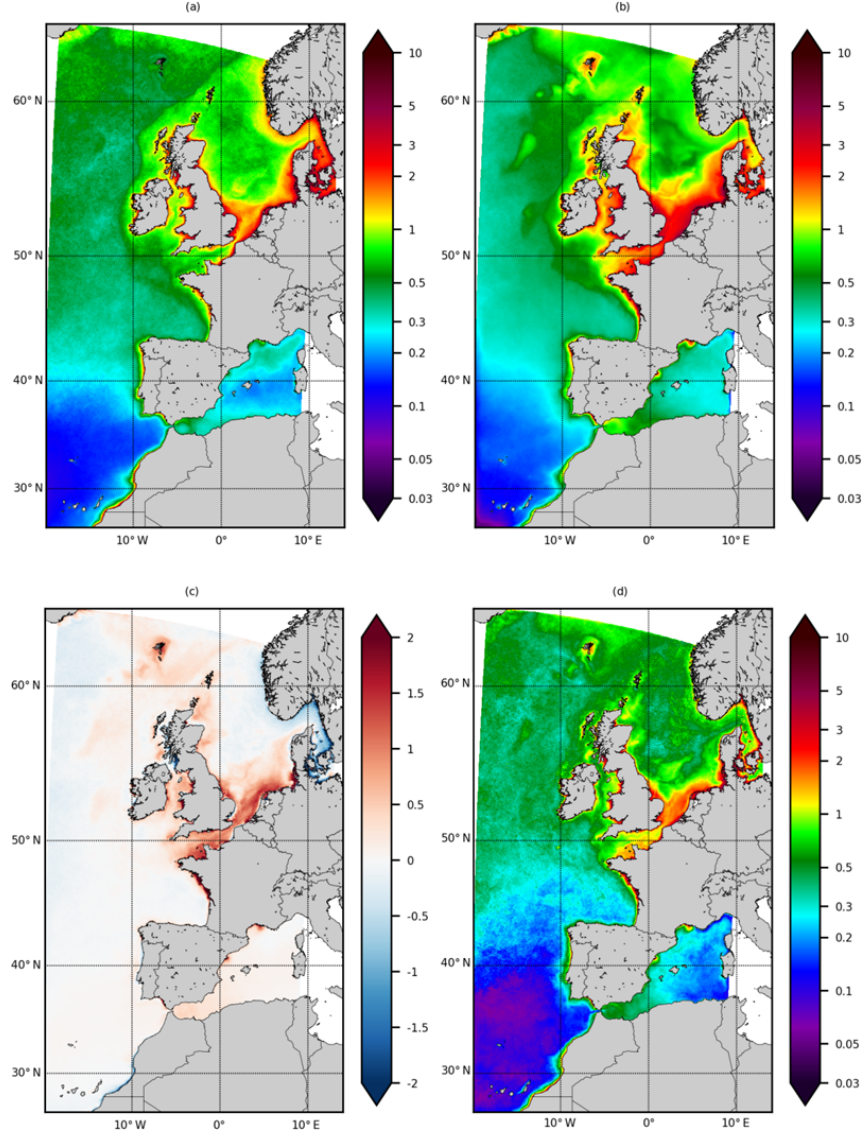
Figure 2. Sea surface Chl a . (a) Annual average of ESA OC-CCI product, (b) annual average of IBI36, (c) averaged bias of Chl a (model − p (cid:104) ( model − obs ) 2 (cid:105) ), all expressed in mgChlm − 3 . Statistics are computed from monthly fields between 2010 and 2016. obs) and (d) RMSE ( Table 1. Synthesis table for Chl a (mgChlm − 3 ) and NPP (mgCm − 2 d − 1 ) assessment against satellite-derived estimations. Mean and p (cid:104) ( model − obs ) 2 (cid:105) , percent bias (%) = | mean error / mean obs | and correlation standard deviation, mean error = (cid:104) ( model − obs ) (cid:105) , RMSE = are computed for the IBI extended domain, using model and observations averaged over the length of the simulation